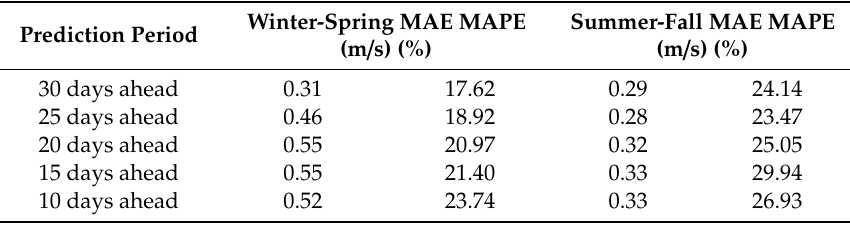
Table 6. MAE and MAPE values for the estimated values of wind power at different future times. Prediction